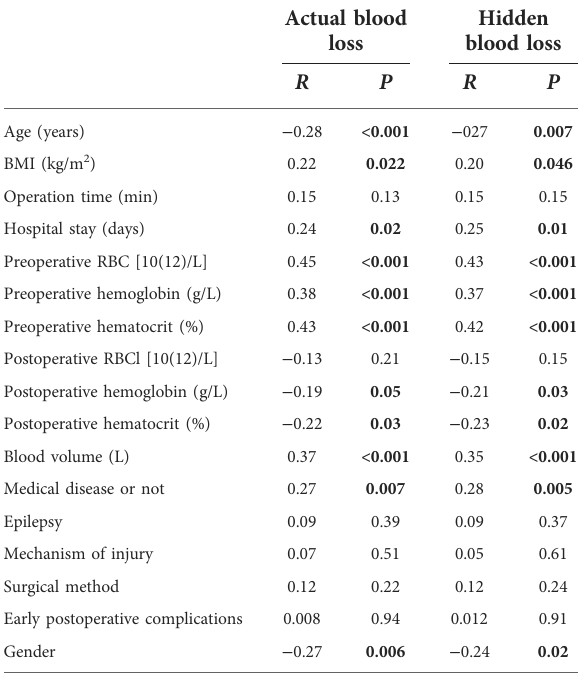
TABLE 3 Correlation between various indicators and actual blood loss and hidden blood loss.